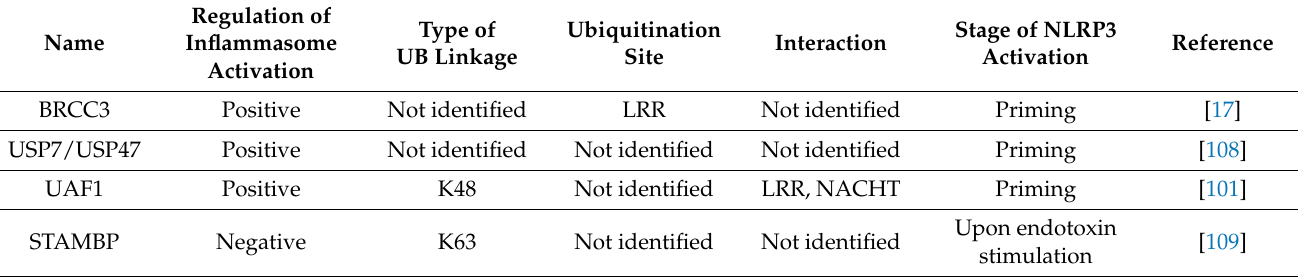
Table 2. Regulation of NLRP3 by